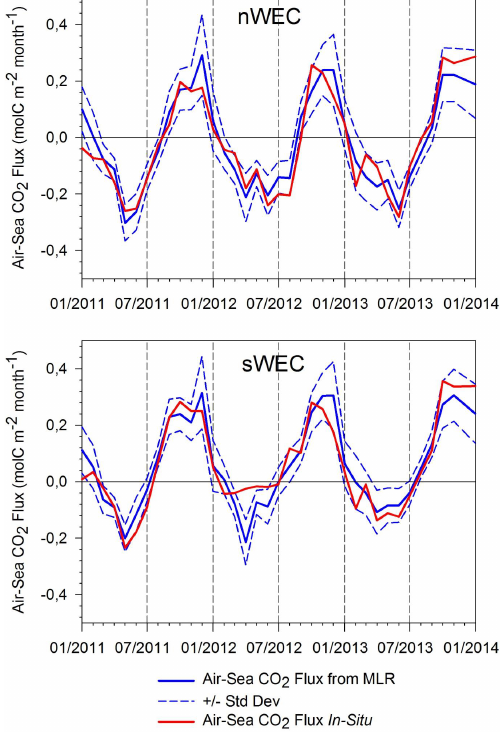
Figure 7. Monthly air–sea CO 2 fluxes (molCm − 2 month − 1 ) com- puted from observed p CO 2 (in red) and p CO 2,MLR (in blue) data in nWEC and sWEC from 2011 to 2013 using Nightingale et al. (2000) gas transfer velocity K . Dashed lines represent fluxes computed from p CO 2,MLR plus and minus respective